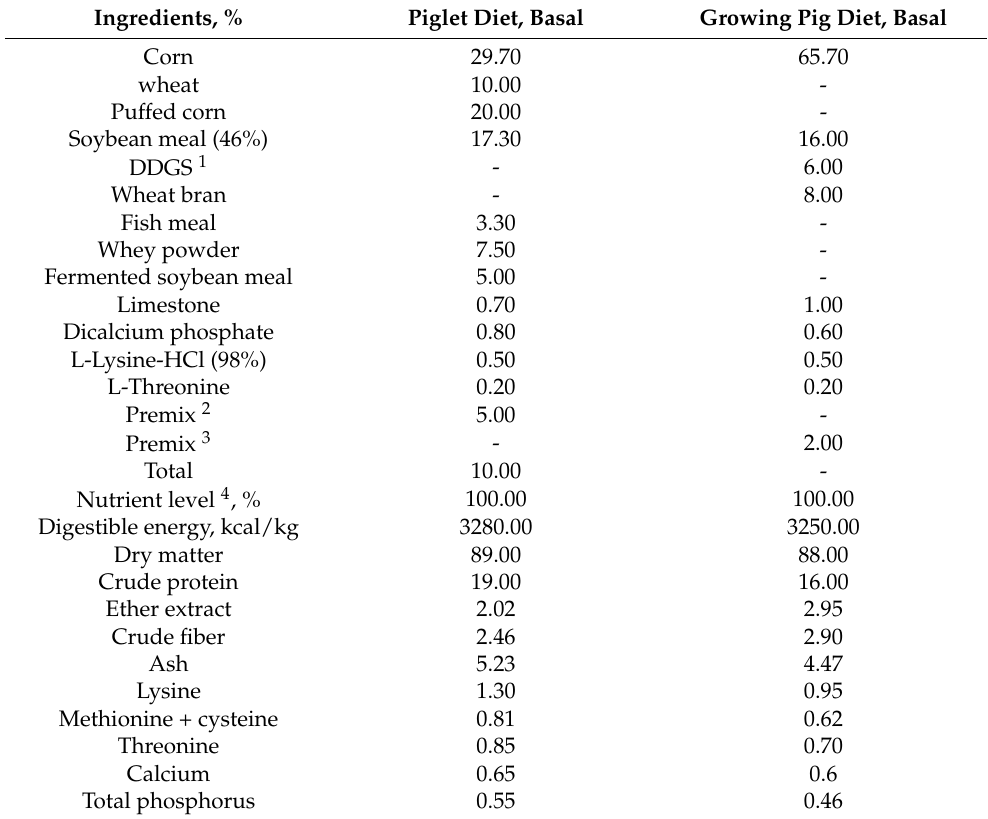
Table 2. Ingredients and chemical composition of experimental diets (air-dry basis).